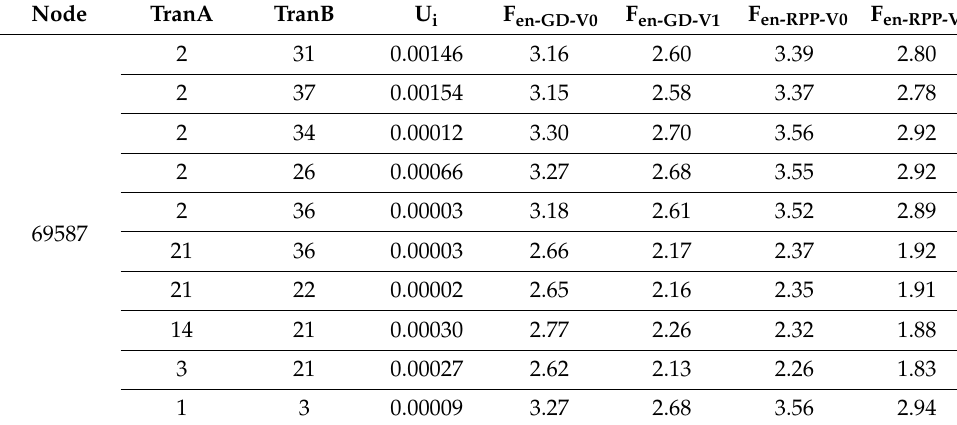
Table 8. F en results of the divider plate in the steam generator. Node